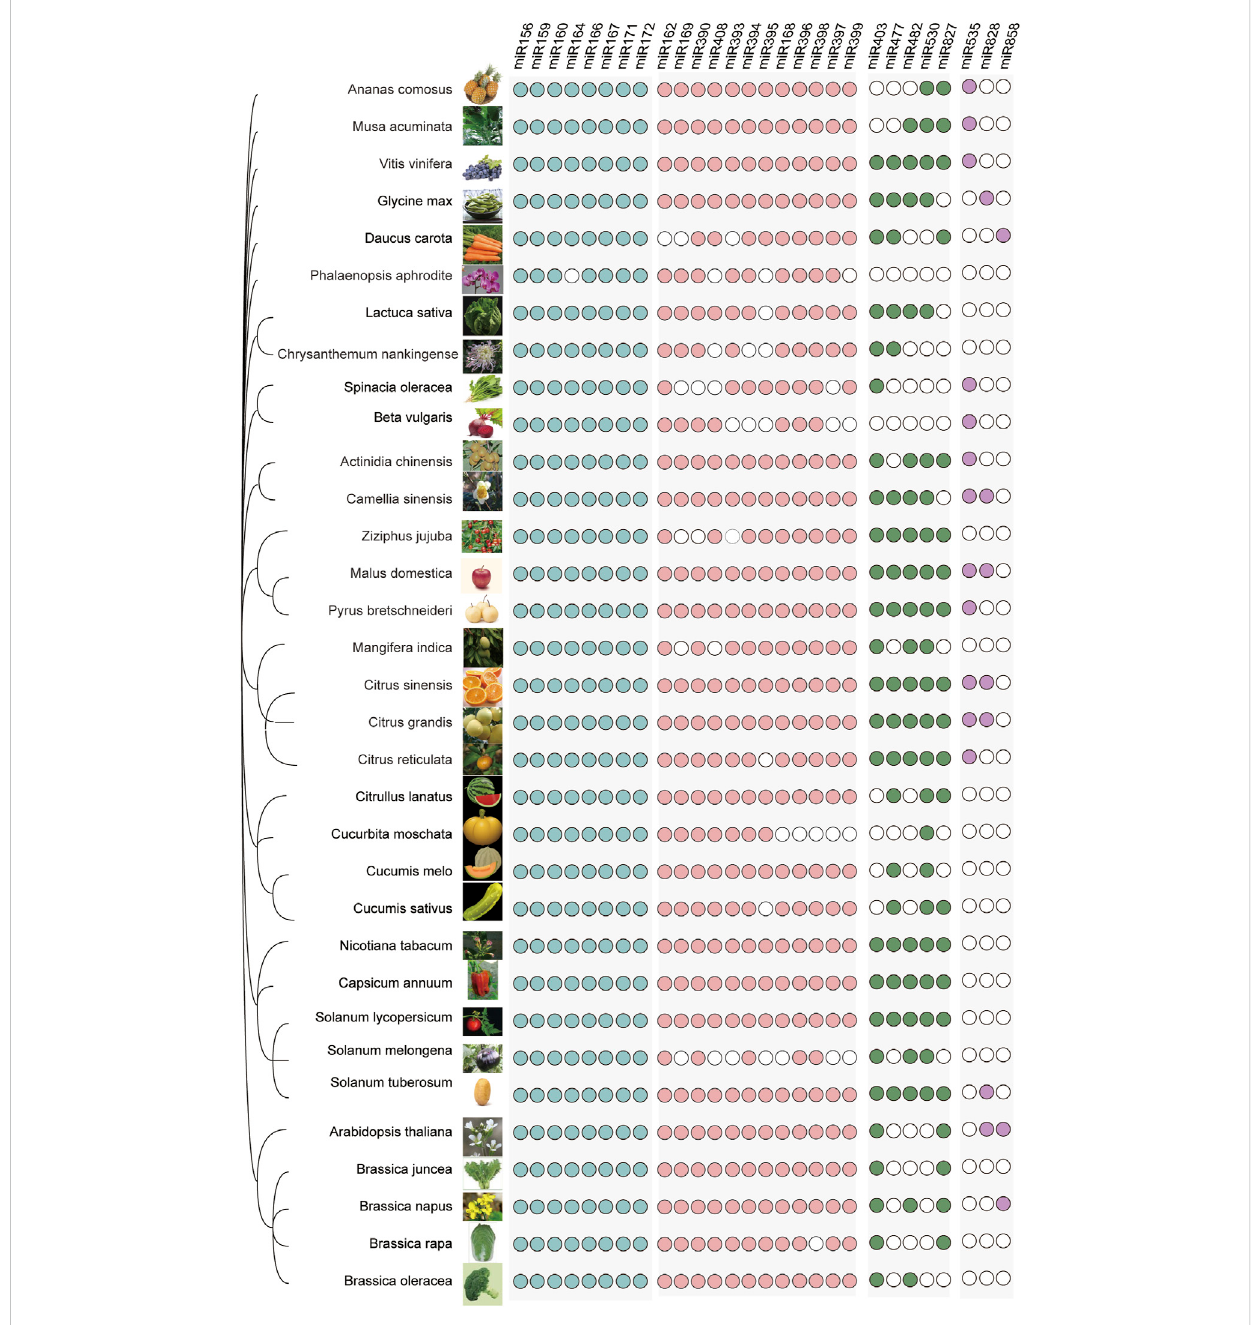
FIGURE 2 Conservation of miRNAs of horticultural plants. A phylogenetic tree of representative horticultural plants is shown on the left; major groups in the top left are the different families of horticultural plants: Asteraceae, Fabaceae, Apiaceae, Chenopodiaceae, Vitaceae, Musaceae, Bromeliaceae, Rhamnaceae, Rosaceae, Actinidiaceae, Rutaceae, Theaceae, Orchidaceae, Cucurbitaceae, Solanaceae, and Brassicaceae. Different miRNAs are listed at the top, grouped by conservativeness. Below the miRNAs, the colored circles indicate the presence of the component, while empty circles indicate the absence of the